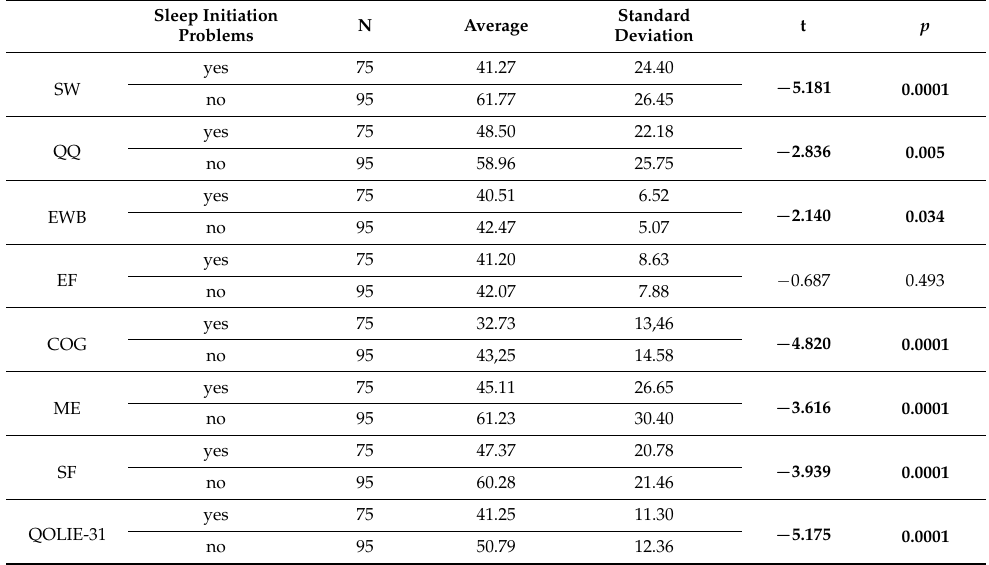
Table 3. QOLIE-31 results in the groups reporting and denying sleep initiation difficulties, a compar- ative analysis (statistically significant correlations p ≤ 0.001 in